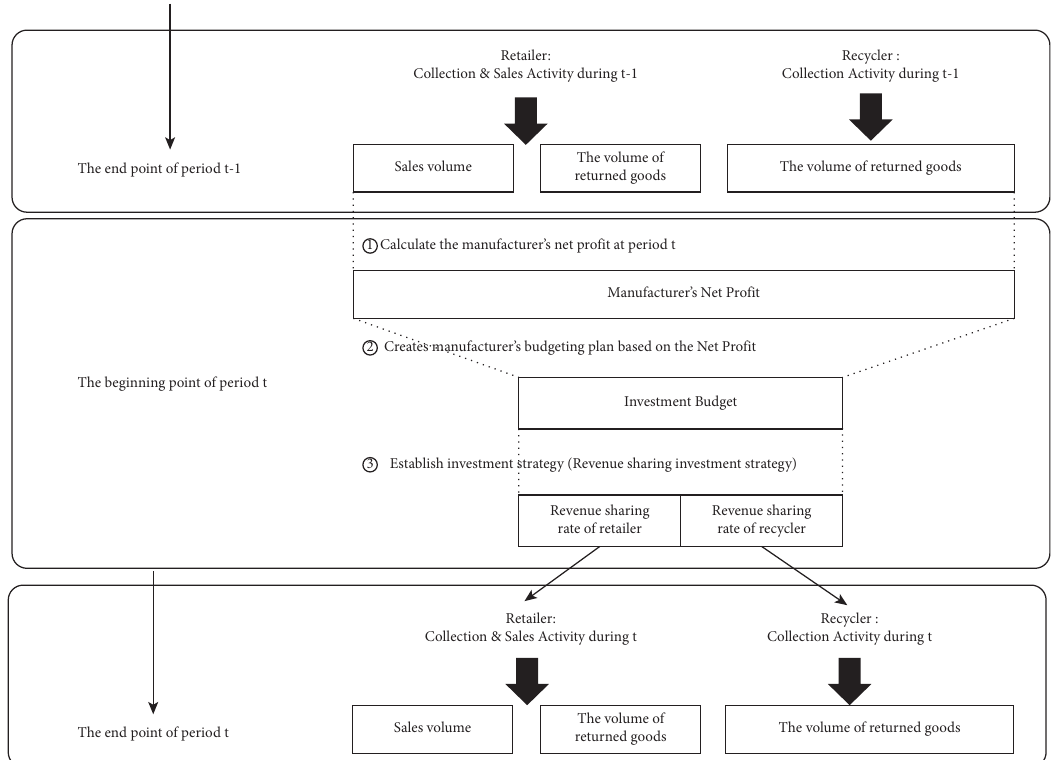
Figure 5: Linear function of the willingness to return according to the change in the customer’s perceived rewards.